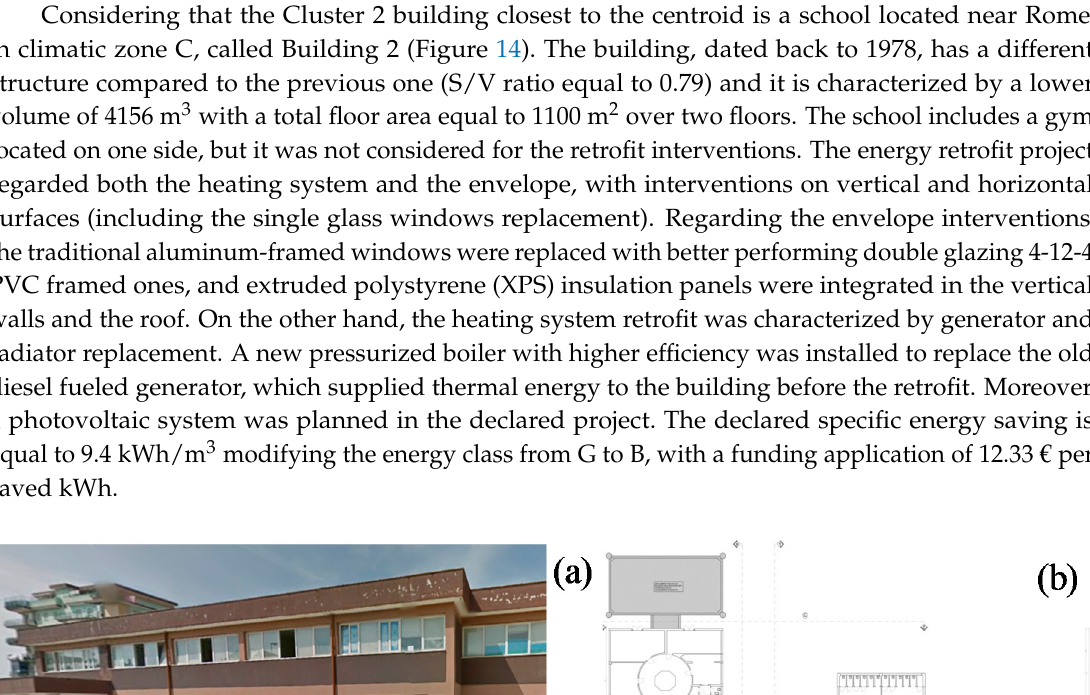
Table 6. Buildings model data set before retrofit.